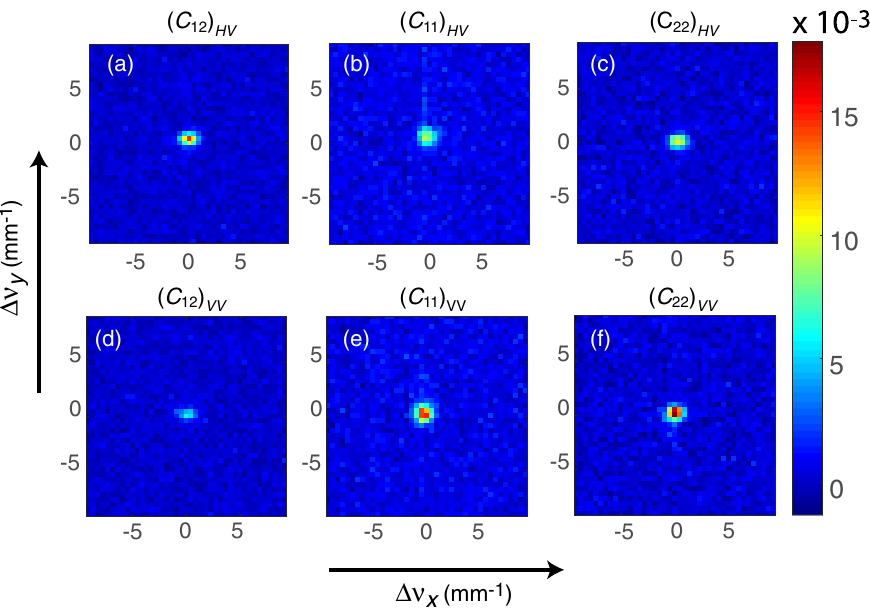
FIG. 3. Average normalized spatial-momentum correlation distributions obtained when correlations are measured between image pairs ( C 12 ) and within single images ( C 11 , C 22 ) when the optical path difference between the two arms of the interferometer is null. Note that HV and VV indices are related to the polarization states of the twin